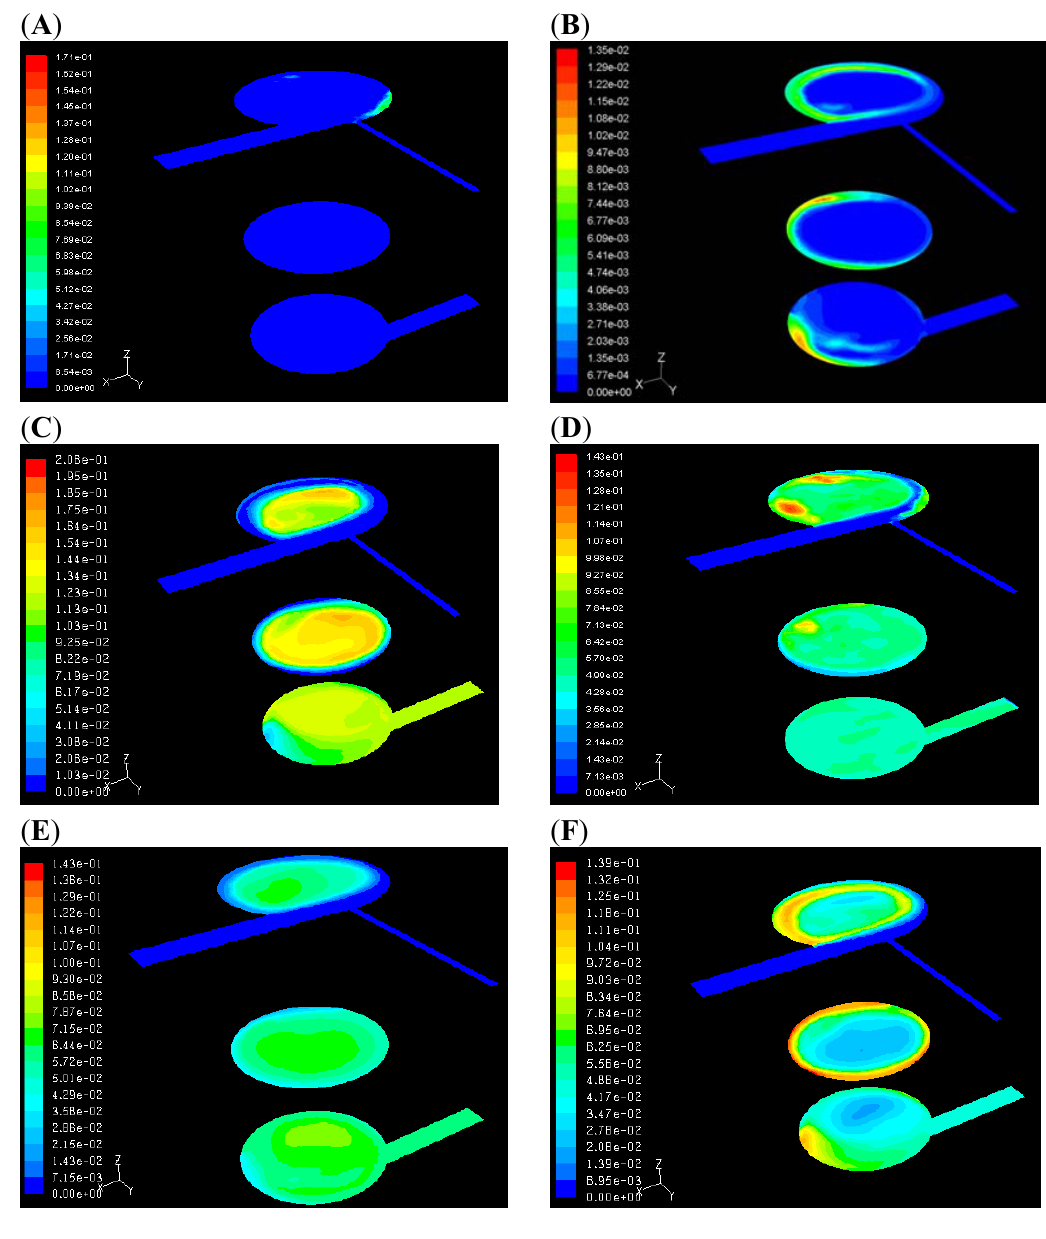
Figure 2. (A) Flamelet: CO map after 0.03 s; (B) EDC: CO map after 0.03 s; (C) EDC: CO map after 0.05 s; (D) Flamelet: CO map after 0.03 s; (E) EDC: CO 2 (F) EDC: CO map after 0.05 s. 2